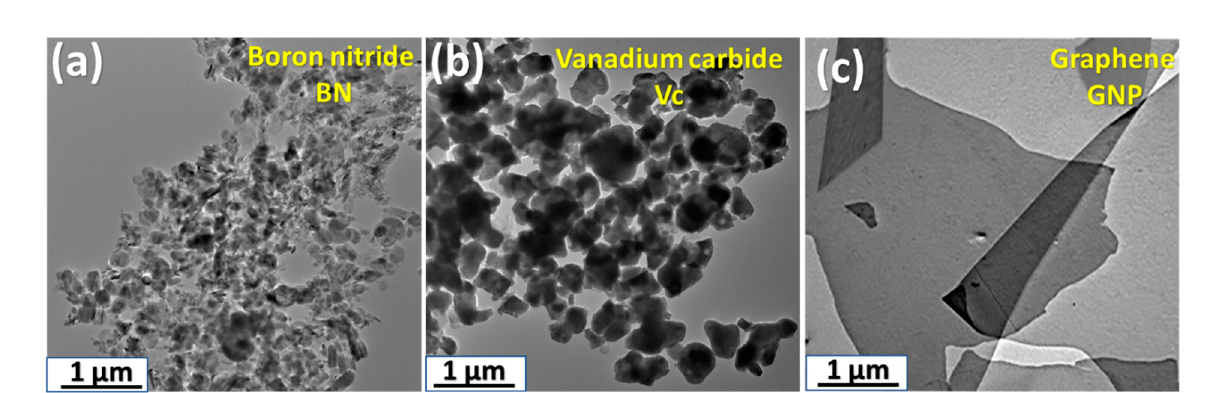
Figure 1. TEM images of the reinforcement particles: ( a ) hexagonal boron nitride nanopowder, ( b ) vanadium carbide particles, ( c ) graphene nanoplate.